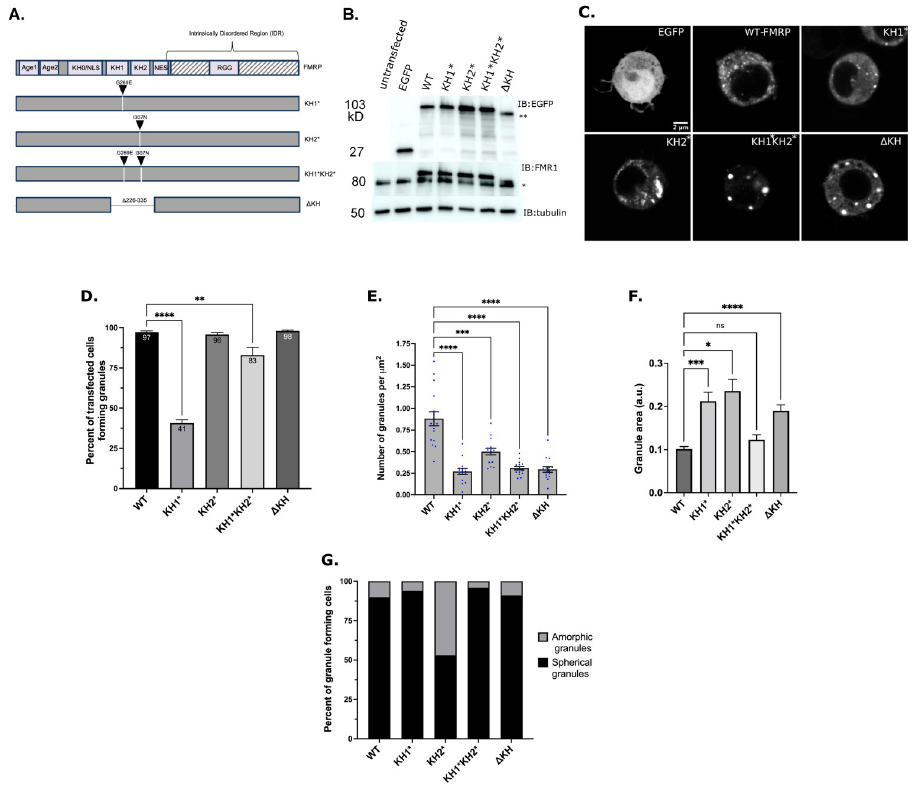
Fig 2. The KH domains differentially regulate FMRP granule formation. (A) Schematic representation of dFMRP variants used in this study. Arrowheads indicate where analogous FXS-causing point mutations were made in dFMRP. Deletion of the KH1 and KH2 domains is annotated with a break in FMRP sequence. (B) Western blot analysis of EGFP (GFP), FMRP, and α -tubulin protein levels in transfected cells. α -tubulin was used as a loading control ( � = 80 kDa, �� = 90 kDa). The upper bands on the FMR1 blot are the EGFP:FMRP fusion protein. (C) Representative images of cells transiently transfected with the indicated GFP-tagged FMRP constructs. Scale bar = 2 μ m. (D) Percentage of transfected cells forming GFP-FMRP granules. Data are presented as mean ± S.E. (approximately 100 cells per three experiments; one-way ANOVA). (E) Quantification of the number of granules per cell, which was normalized to cell area in μ m 2 (mean ± SE; n = 15 cells each; Brown-Forsyth test). The data shown for the WT controls in Fig 2E are identical to those shown in Fig 1E. The cells analyzed are otherwise from an independent experiment. (F) Quantification of the relative size of granules (a.u.) in a new experiment (mean ± SE; Kruskal-Wallis test). Number of granules analyzed was WT = 209 (8 cells), KH1 � = 85 (13 cells), KH2 � = 127 (15 cells), KH1 � KH2 � = 110 (14 cells), Δ KH = 118 (15 cells). (G) Quantification of the two major morphological phenotypes observed (n = 100 cells each). In D-F, �� p < 0.01, ��� p < 0.001, ���� p <